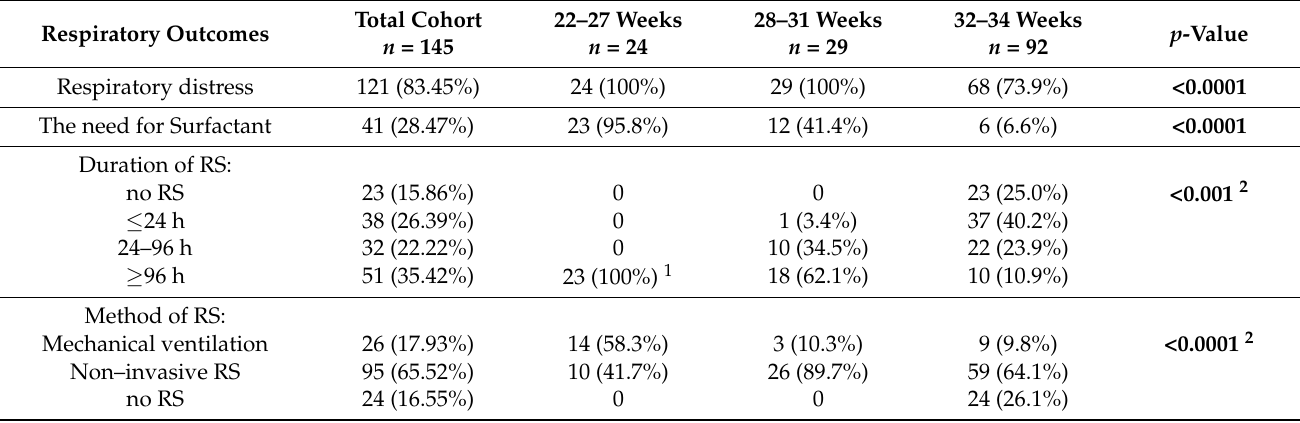
Table 5. The analysis of respiratory outcomes according to gestational age. RS—respiratory support; RDS—respiratory distress syndrome; BPD—bronchopulmonary